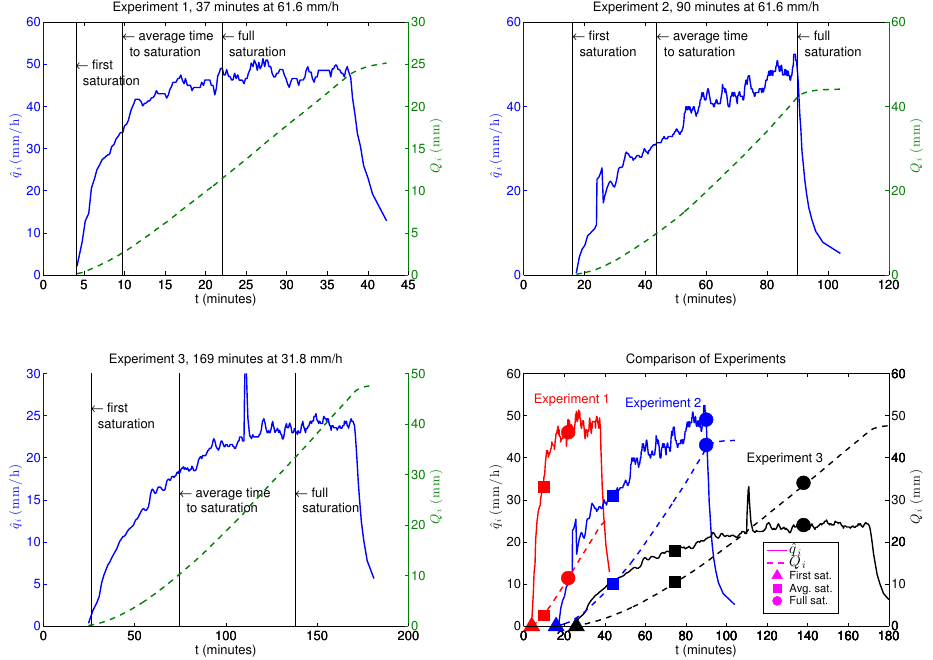
Figure 10. Runoff rate and cumulative runoff for the three experiments. The vertical lines represent times when the soil moisture probes reached maximum values.